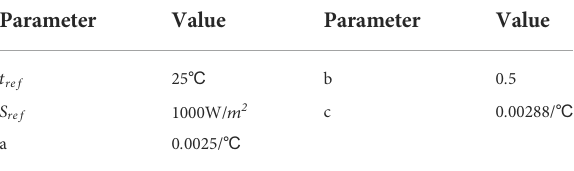
TABLE 1 PV module related